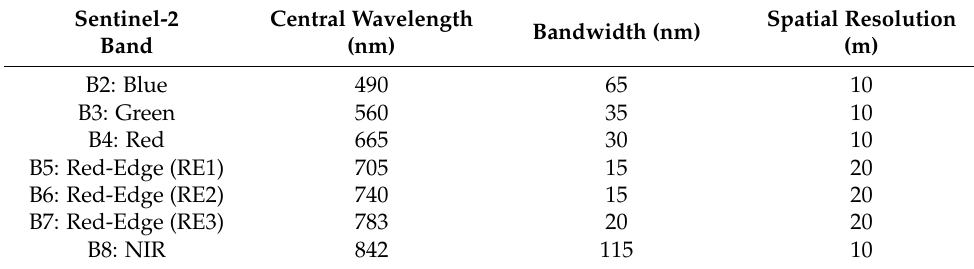
Table 1. Spectral bands of the Sentinel-2 sensors used in VIs of this